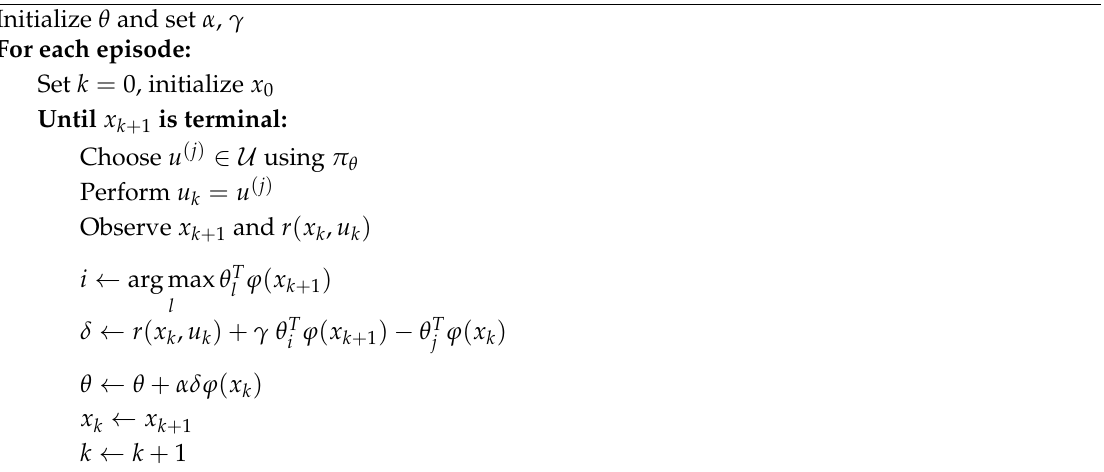
Algorithm 1 Q-learning algorithm with linear function approximation